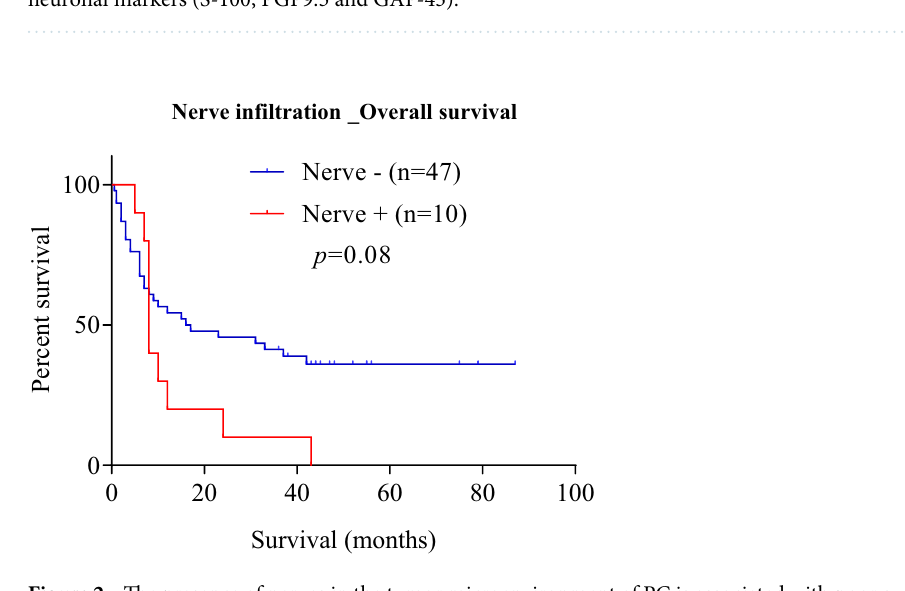
Figure 2. The presence of nerves in the tumor microenvironment of PC is associated with poor survival. Kaplan–Meier survival curve comparing cases positive versus negative for nerve infiltration. Patients with nerve infiltration harbor the worst prognosis i.e. had shorter overall survival compared to without nerve infiltration. The results of comparative analyses are presented in Table 2. PC pancreatic